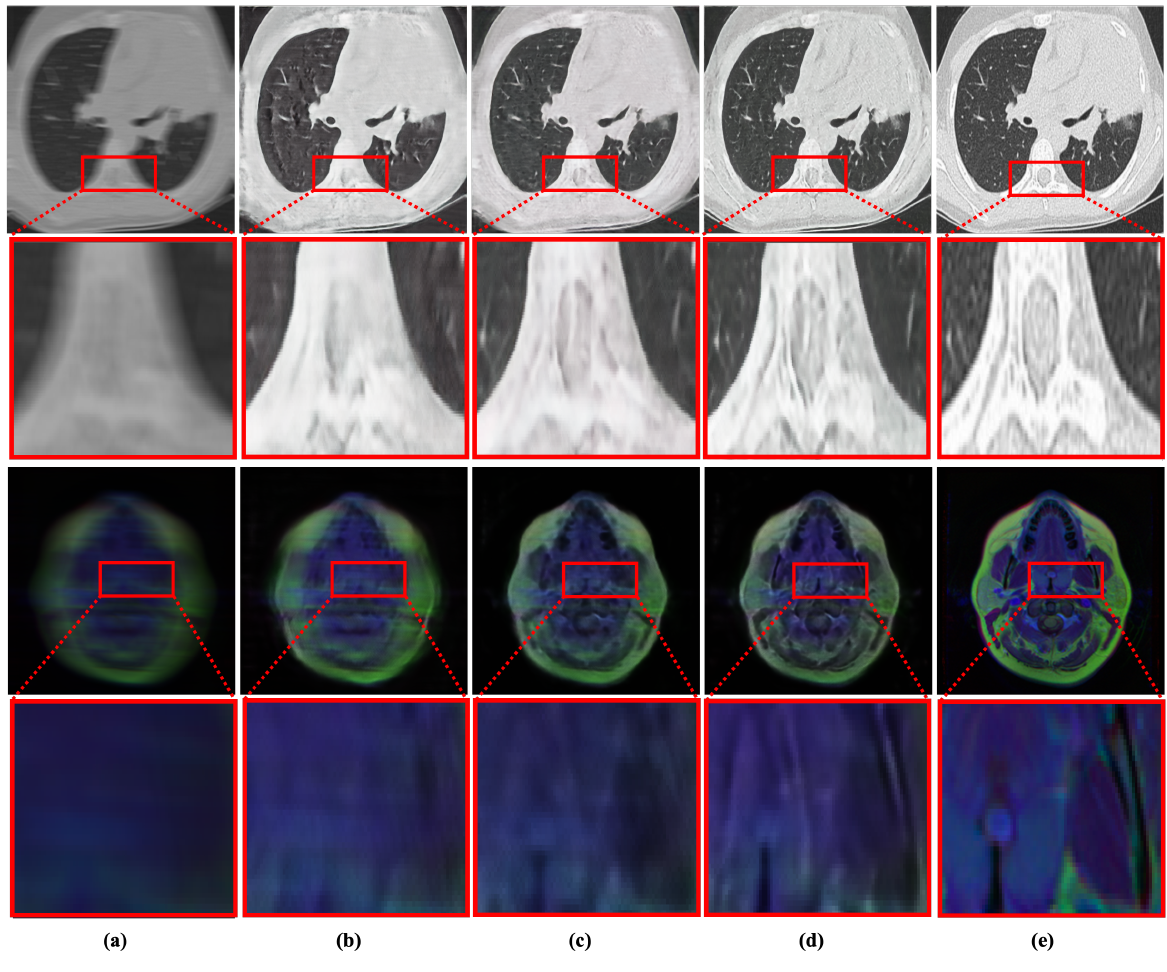
Figure 8. Qualitative evaluation of the impact of proposed components in MID. ( a ) Blurry Input. ( b ) Base network. ( c ) Base network + scale-recurrent structure. ( d ) Proposed network with scale- recurrent structure + RD-SAM. ( e ) Reference image.